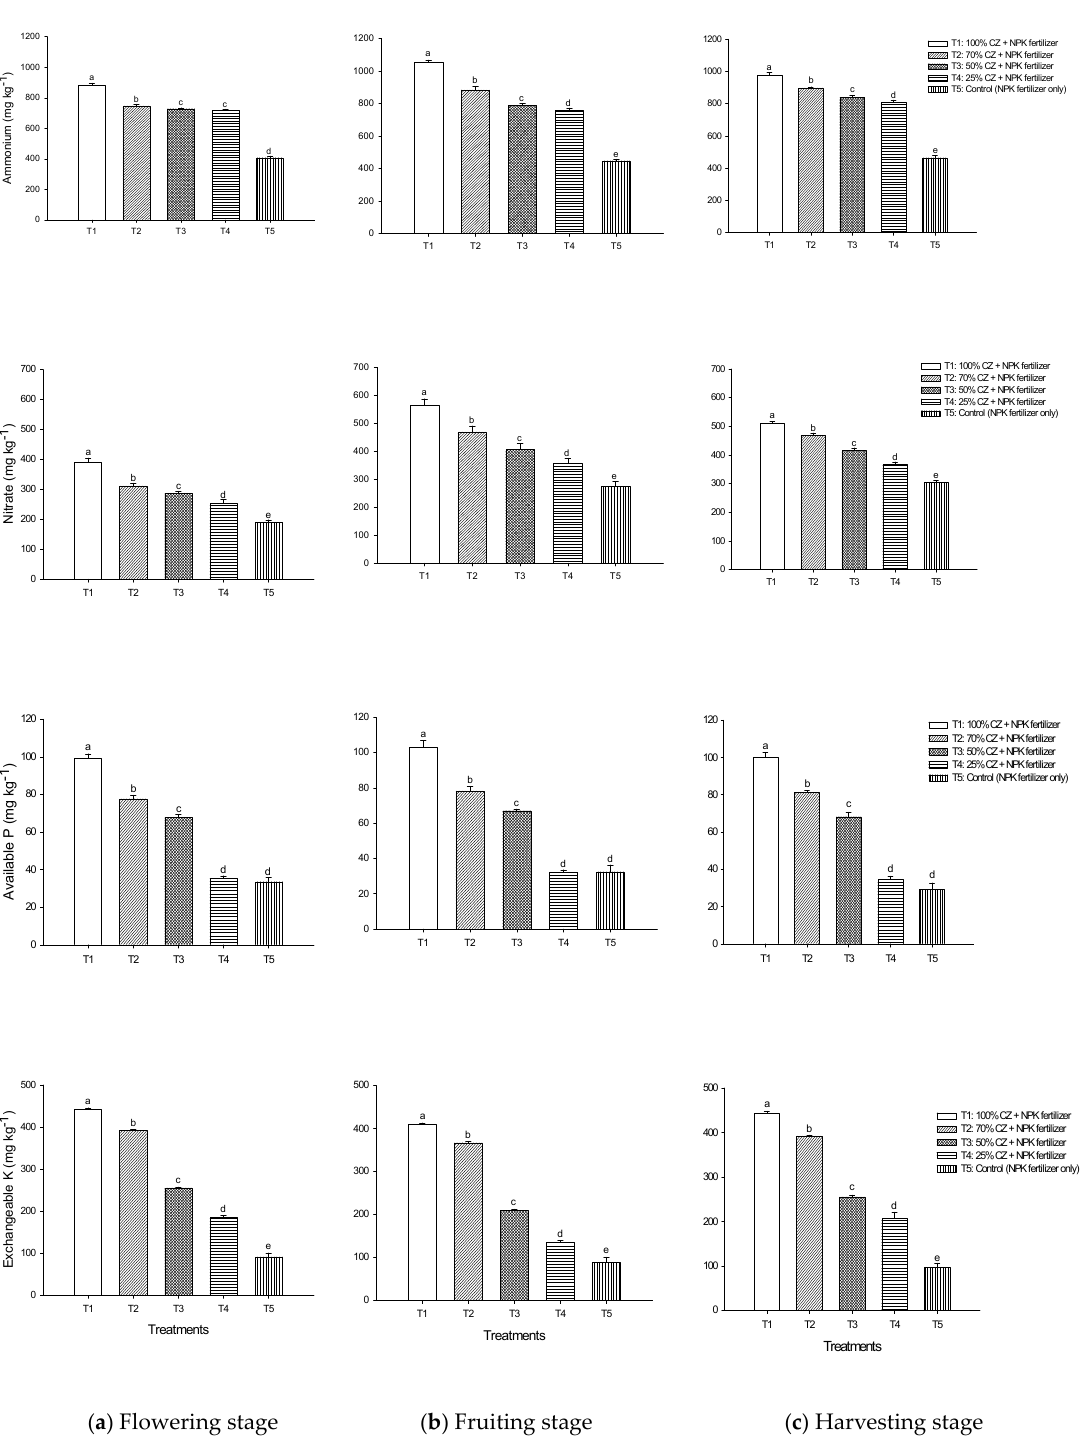
Figure 2. Exchangeable ammonium, available nitrate, available phosphorus, and exchangeable potassium in a peat soil treated with different amounts of CZ and NPK fertilizer throughout papaya plant growth stages: ( a ) flowering stage; ( b ) fruiting stage; and ( c ) harvesting stage. Error bar represents standard error of the mean. Means with different letters indicate significant difference between treatments by Tukey’s test at p ≤ 0.05. CZ: clinoptilolite zeolite; T1: 100% CZ + NPK fertilizer; T2: 70% CZ + NPK fertilizer; T3: 50% CZ + NPK fertilizer; T4: 25% CZ + NPK fertilizer; T5: Control (NPK fertilizer only).